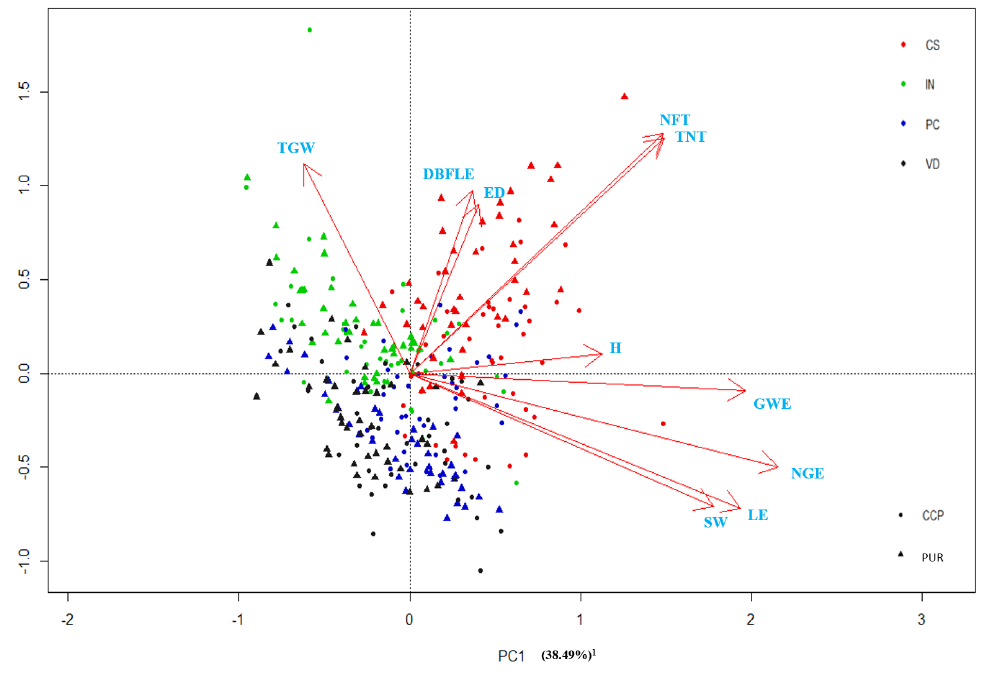
Figure 4. Graphic representation of the first and third components (PC1 and PC3) of the Principal Components Analysis. The different colours distinguish the four different sites: VD, IN, PC and CS. CCP = Composite Cross Population, PUR = Pure line. 1 The percentage indicates the contribution of the component to the explanation of the total variation of data. Red arrows indicate measured parameters. Their abbreviations are detailed in Table